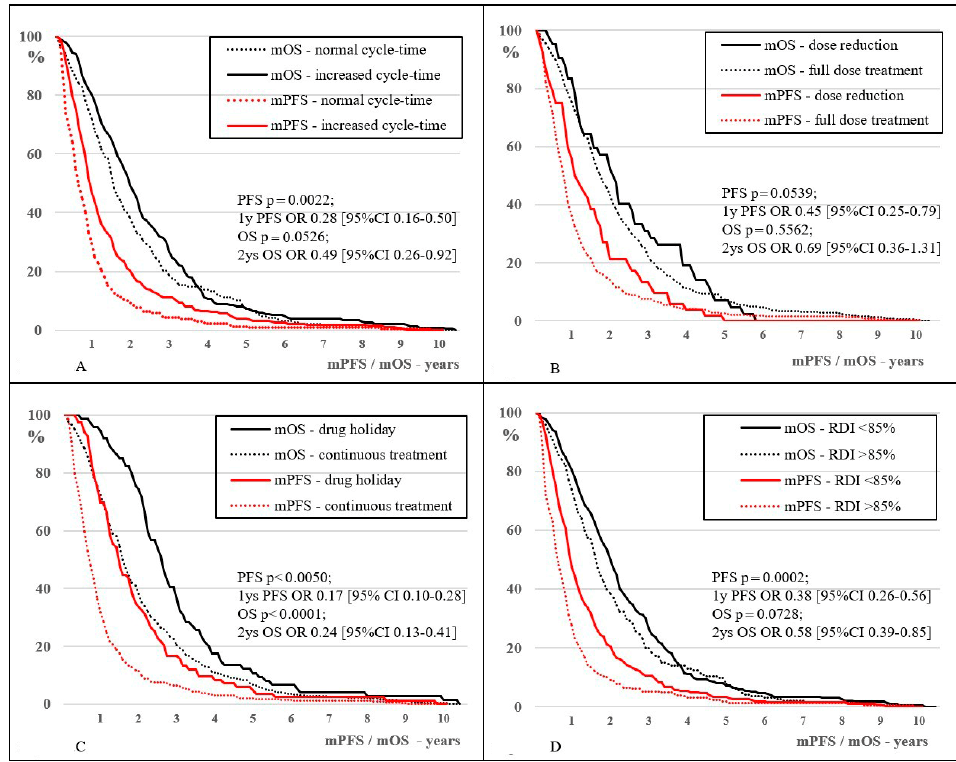
Figure 4. Kaplan–Meier curve for comparing mPFS and mOS of: ( A ) normal and extended cycle-time treatments (below or under 20% cycle-time extension); ( B ): full-dose and dose-reduced (any grade) treatments; ( C ): patients who had and a drug holiday and those who did not; ( D ): treatments with RDI above and below 85%.